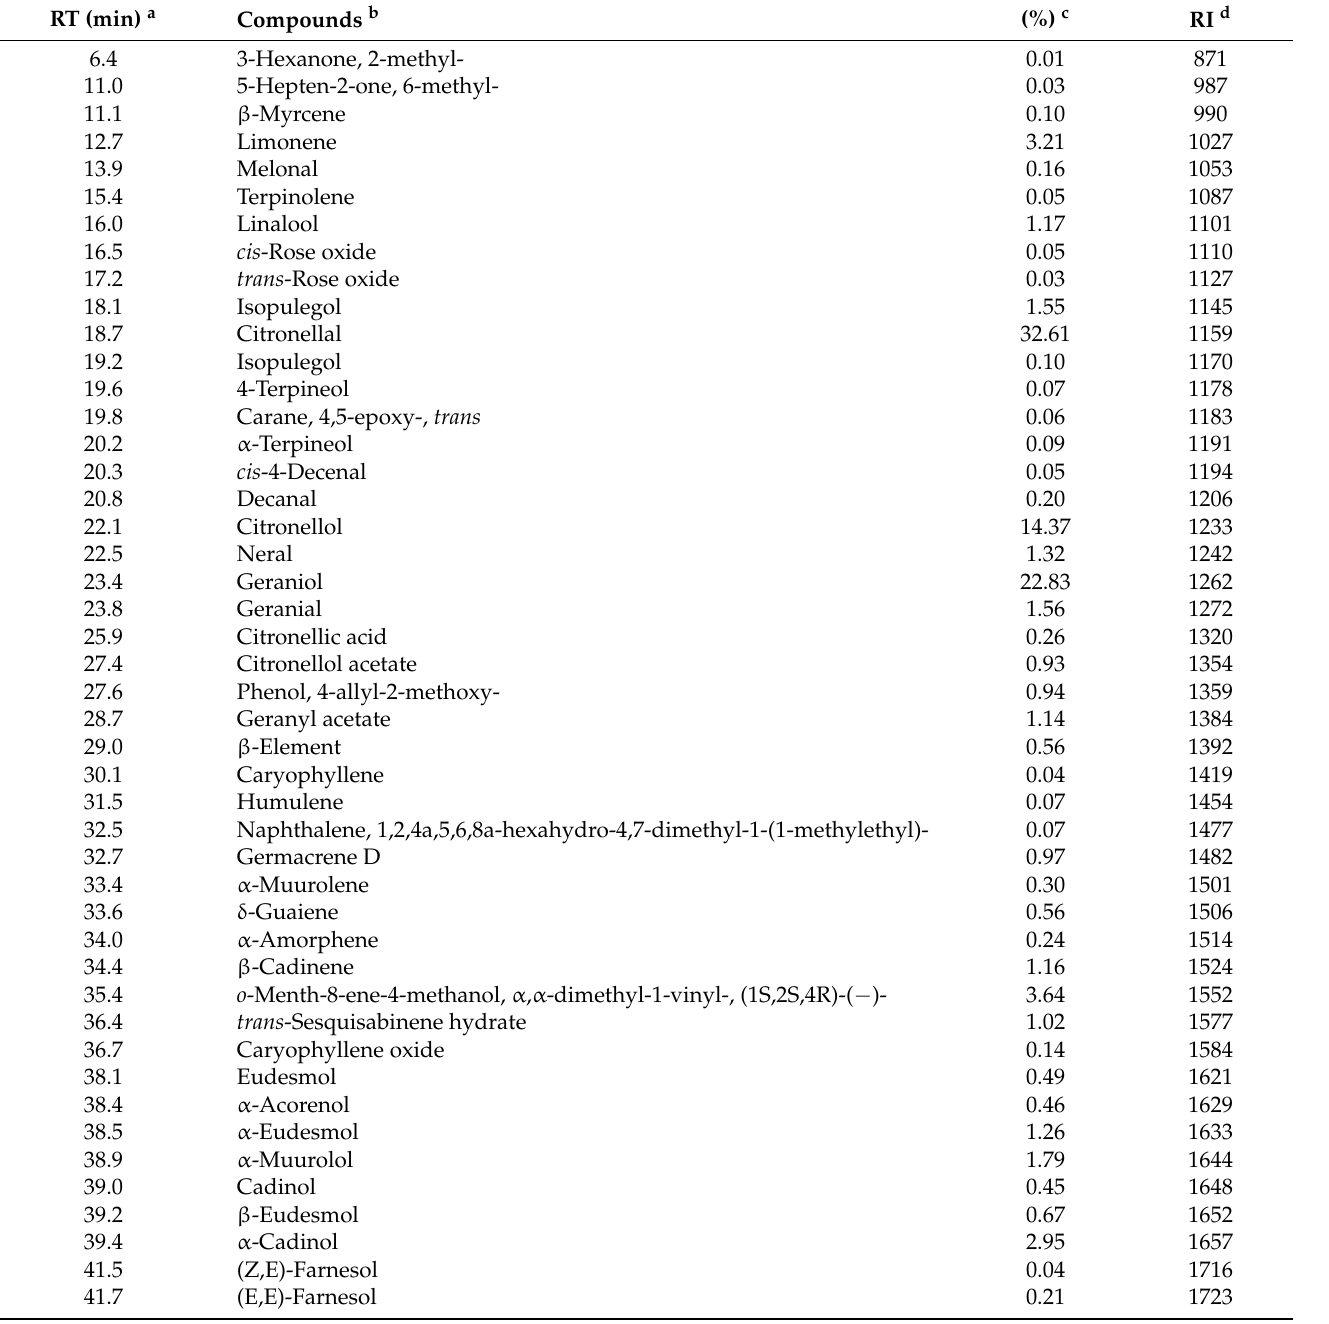
Table 3. Chemical composition and retention indices of the chemical constituents of the